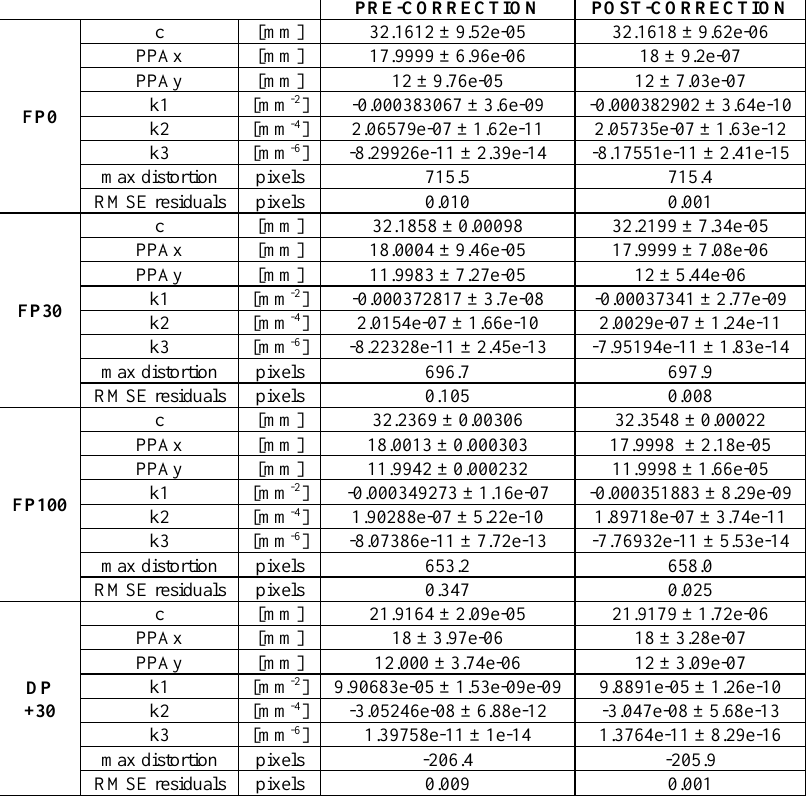
Table 2. Results of the bundle adjustment with self-calibration for the simulated dataset before and after the polynomial distance- depend